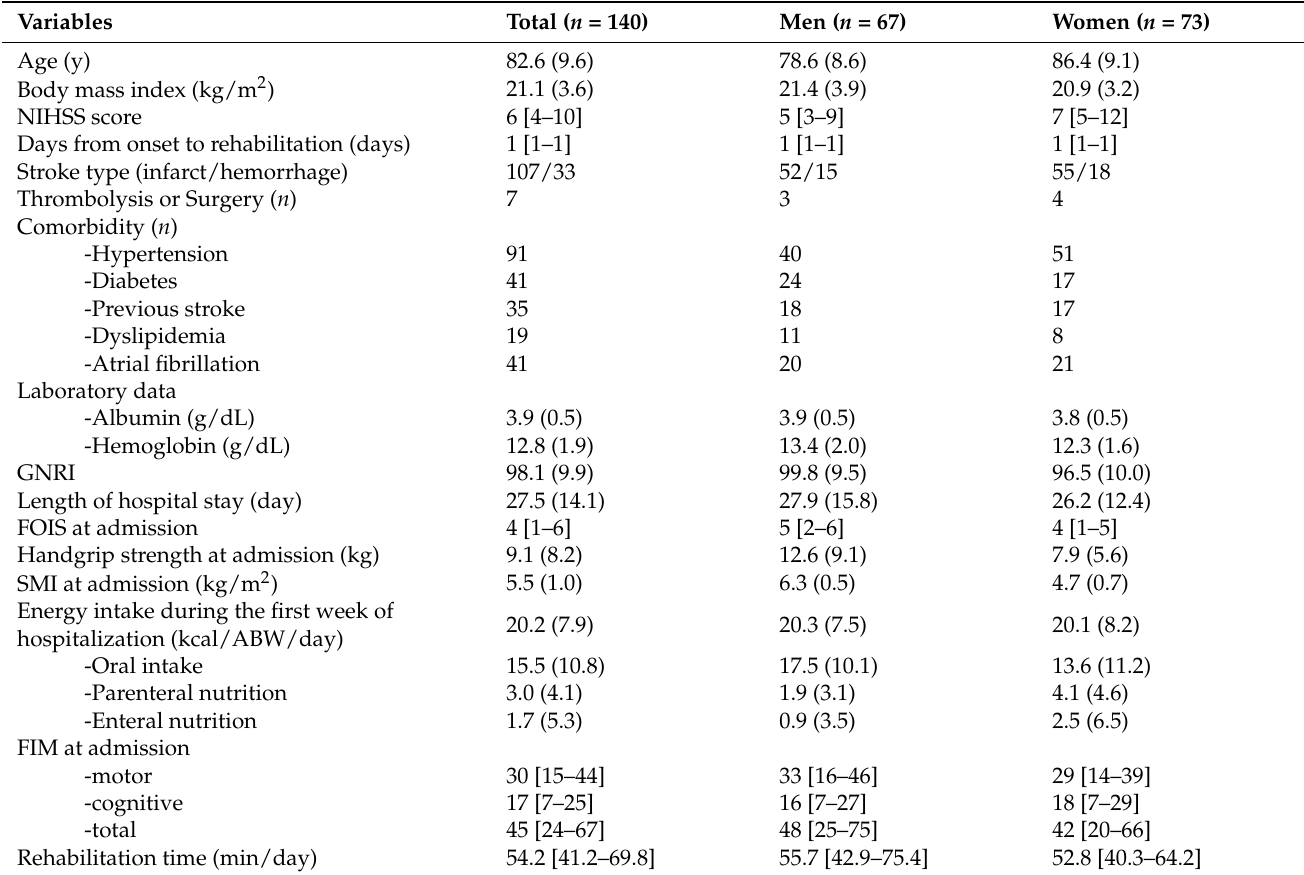
Table 1. Patient characteristics.